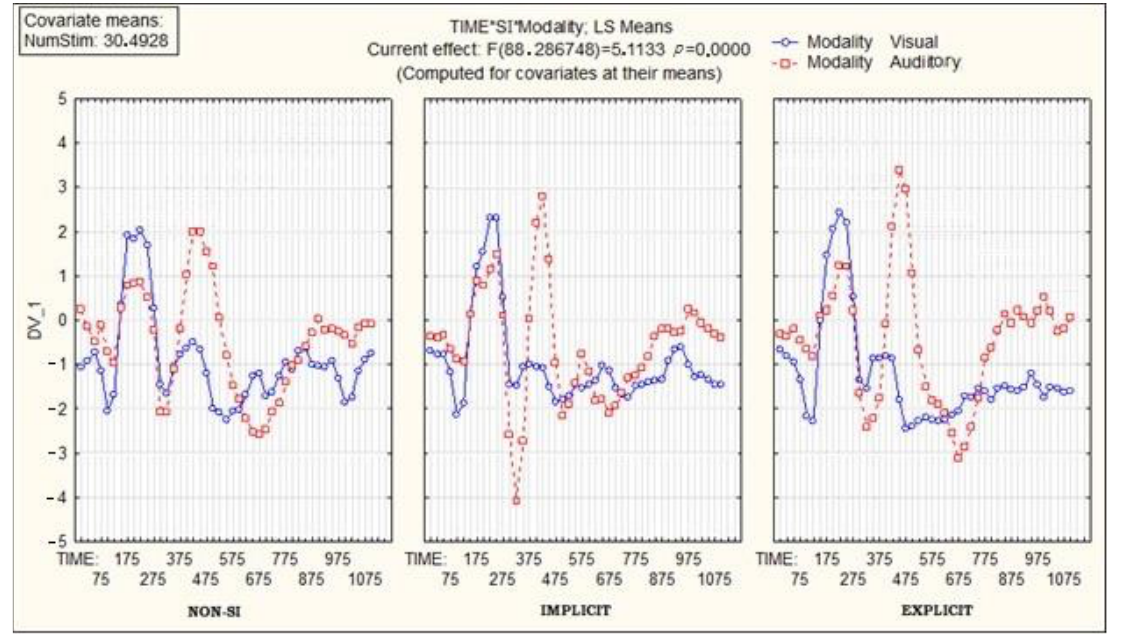
Figure 2. Differences between three groups of stimuli (explicit and implicit SI words and non-SI words) in both modalities (visual and auditory). '*' is a multiplication sign.